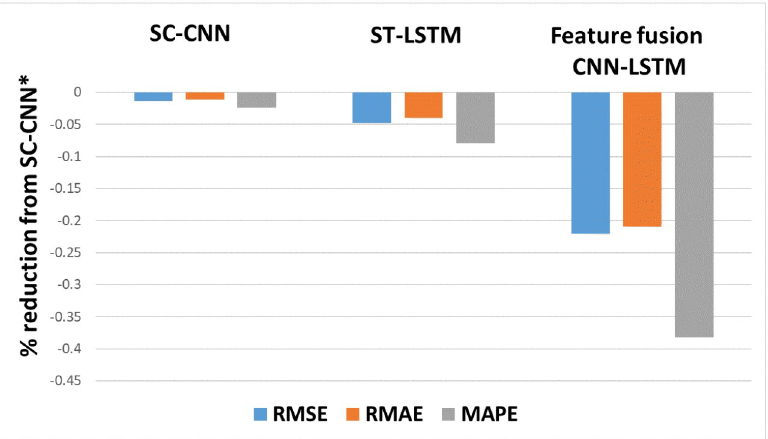
Fig 12. Comparison of prediction errors among three models based on SC-CNN � . The input data are candlebar charts, which are the best performing fusion chart images, and stock time series data. Note: SC-CNN � uses a candlestick chart, which is a stock chart image